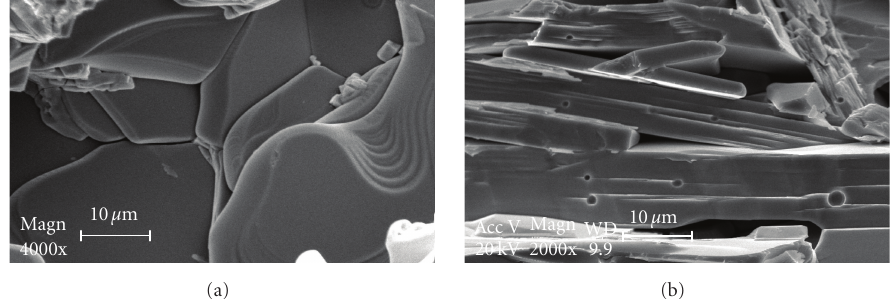
Figure 2: SEM images of grain-oriented BIT ceramics (a) perpendicular and (b) parallel to the press direction.